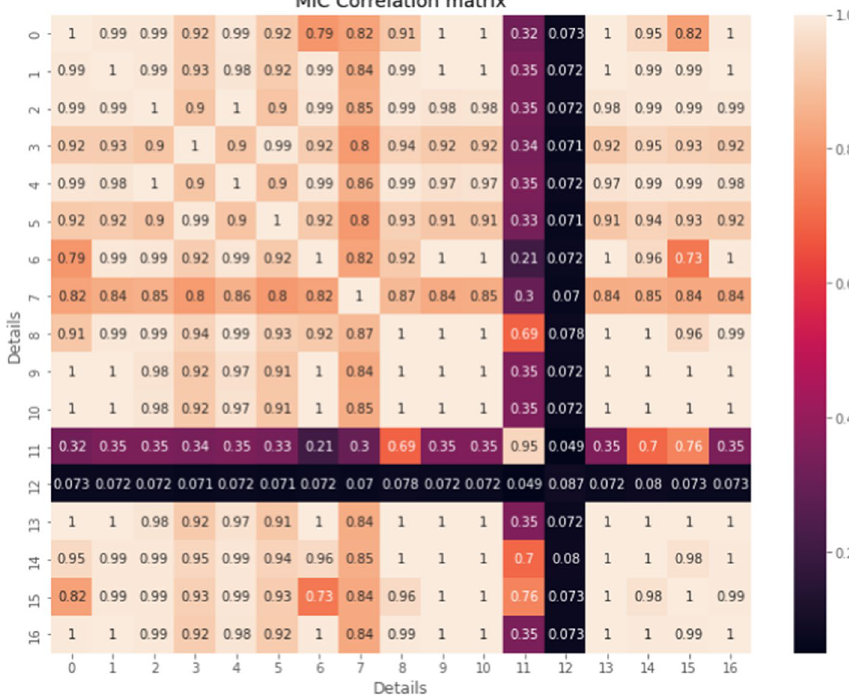
Fig. 8 MIC correlation matrix